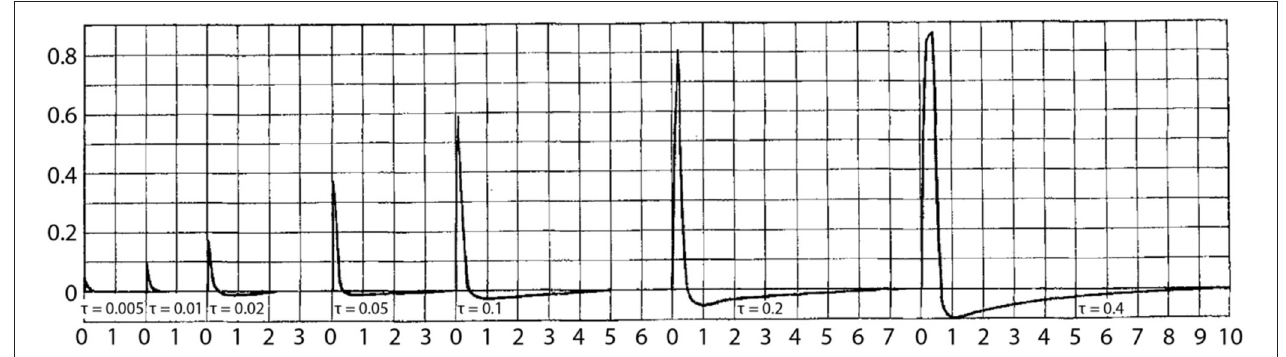
FIGURE 4 | Cupula movement during short rotation periods. Descriptions as in Figure 3